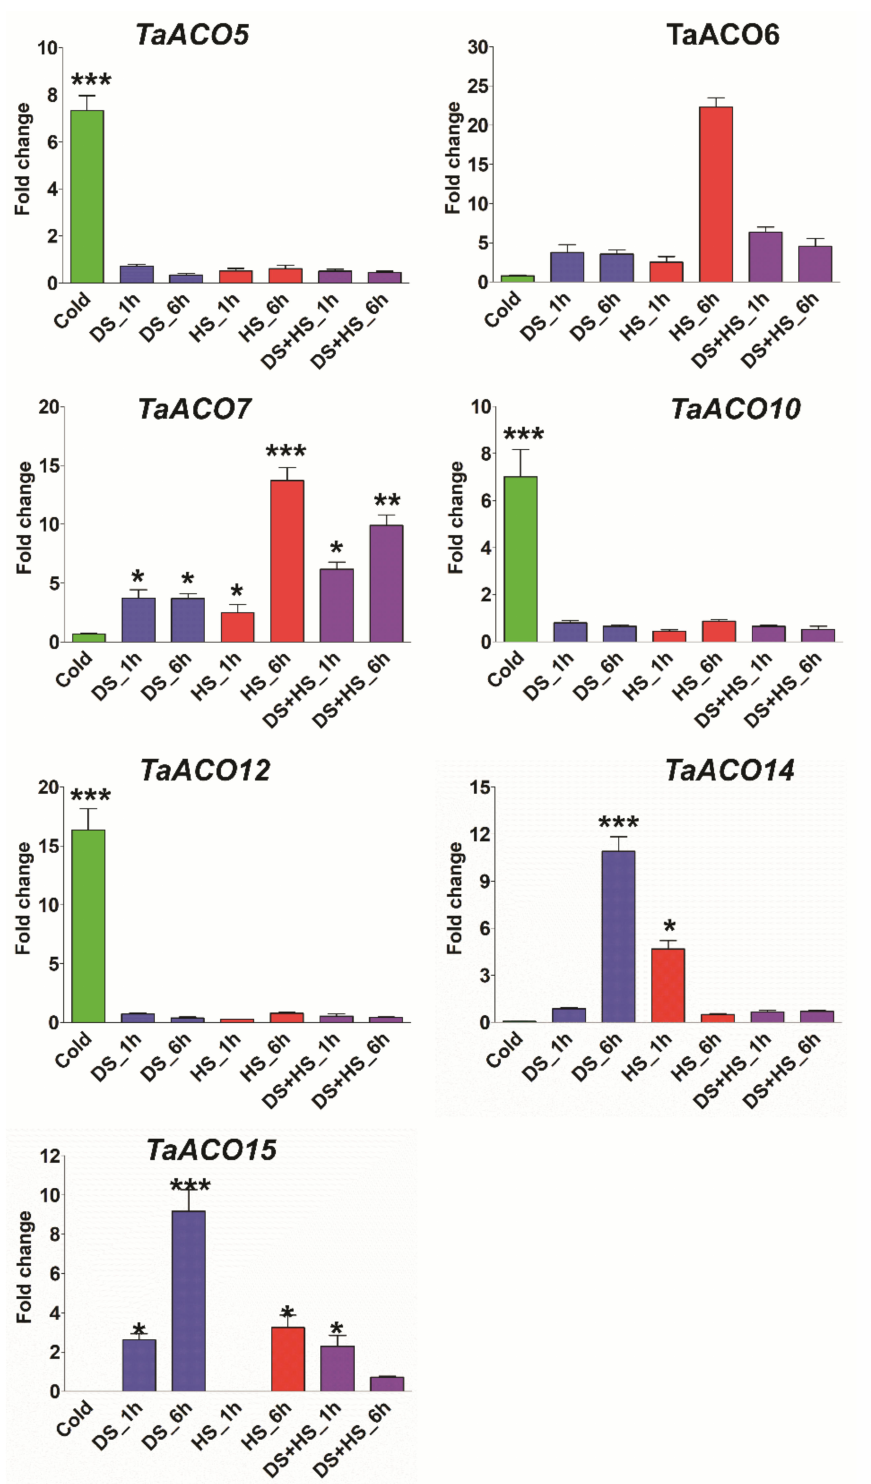
Figure 9. qRT-PCR analysis of randomly selected TaACO genes in different stress conditions to validate RNA seq data. The wheat actin gene was used as the internal control. The Asterisk denotes significant variances compared to the control, top of the bars signifies outcomes of the Tukey HSD test at the <0.05 (* p < 0.05) ** p lies in between the values of 0.05 and 0.001, and <0.001 level (*** p < 0.001). *** meaning expression is significantly induced compared with others. Error bars display standard deviation (SD). Data are mean ± SD ( n =